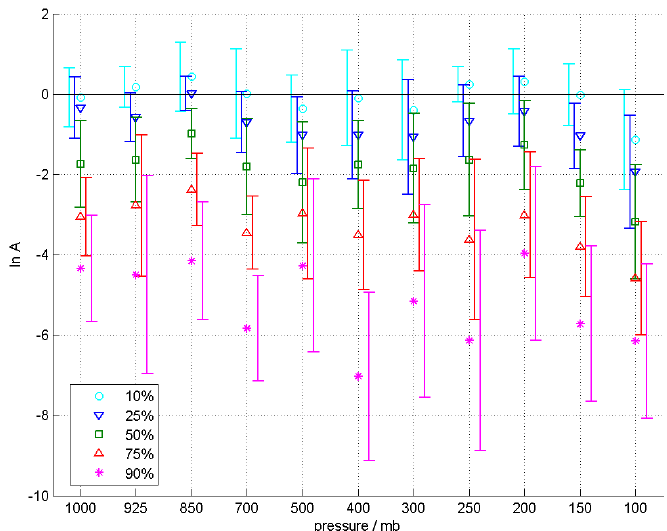
Figure 12. Results and vertical profile for ln A at the five percentiles: 10%, 25%, 50%, 75%, and 90%. The error bars shown are for the 98% confidence interval.